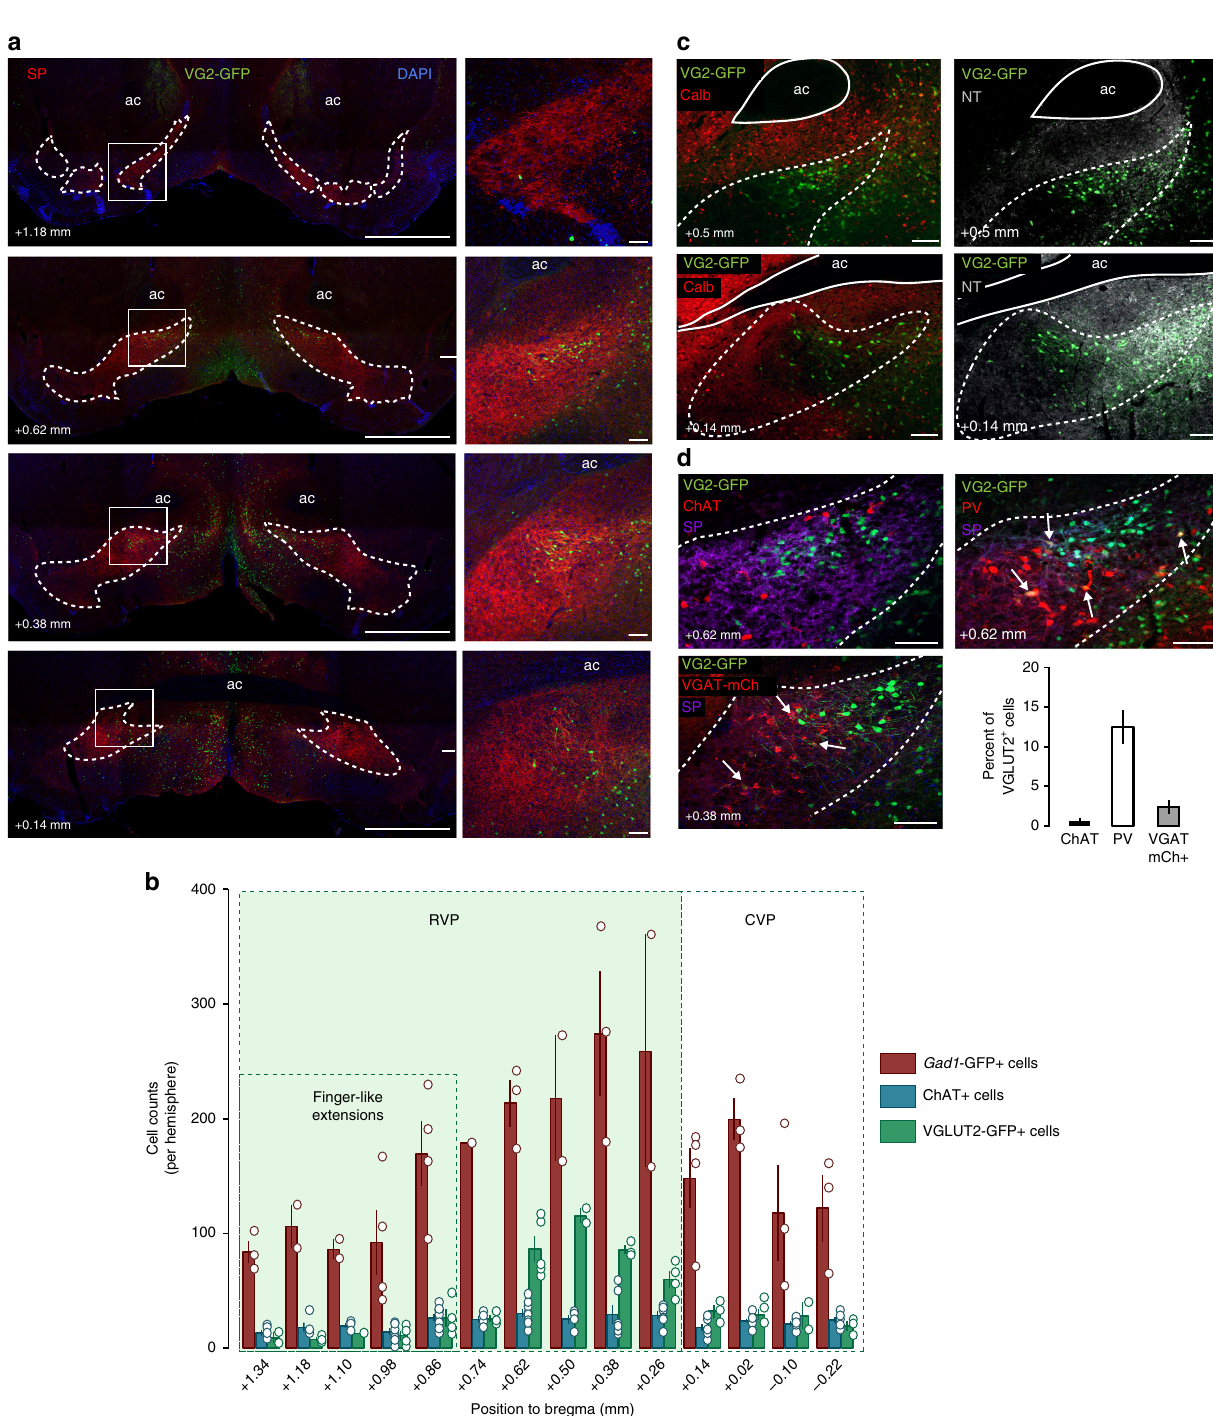
Fig. 1 Localization and histochemical characterization of VP glutamate neurons. a Coronal images through the rostro-caudal axis of the VP of VGLUT2-GFP (VG2-GFP; green) reporter mice. b VGLUT2 + neurons were observed throughout the rostro-caudal axis but most abundant in centro-rostral VP (1791 VGLUT2 + cells, 44 sections, fi ve mice). Gad1 -GFP mice were used to assess GABA neurons (6196 Gad1 -GFP + cells, 39 sections, four mice) and all sections were stained and assessed for the cholinergic marker ChAT (1901 ChAT + cells, 83 sections,nine mice). c Identi fi cation of the dorso-lateral subregion of the VP (VPdl) using antibodies directed against Calbindin (Calb), and the ventromedial subregion (VPvm) using antibodies directed against neurotensin (NT) show the densest cluster of VGLUT2 + cells in the VPvm. d Co-localization of VGLUT2 + cells with ChAT (1078 VGLUT2 + cells, eight VGLUT2 + ChAT + cells, 36 sections, three mice), Parvalbumin (PV) (1692 VGLUT2 + cells, 200 VGLUT2 + PV + cells, 44 sections, four mice), or VGAT (820 VGLUT2 + cells, 19 VGLUT2 + VGAT mCh + cells, 16 sections, three mice). Substance P (SP) was used to delimitate VP boundaries in a and d , DAPI nuclear stain is shown in a , all distances are relative to Bregma, and cell counts or percent of VGLUT2 + cells expressed as mean ± SEM. Scale = 1 mm ( a ; left panels) and 100 µ m ( a ; right panels, c and d ). See also Supplementary Figure